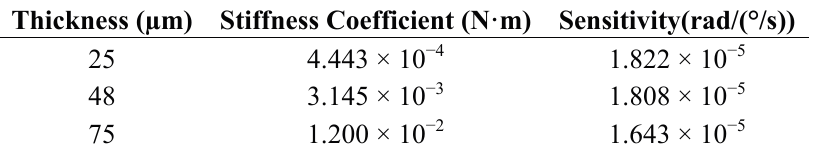
Table 1. The sensitivity of gyro for different beam thicknessess.